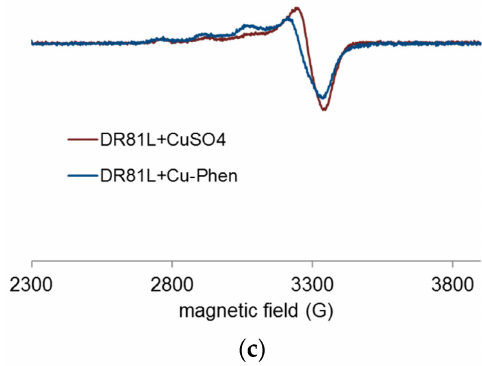
Figure 22. Experimental X-band EPR spectra recorded at 100 K in frozen aqueous solutions of ( a ) CuSO 4 and CuSO 4 + DR81 ( b ) Cu-Phen and Cu-Phen + DR81 ( c ) CuSO 4 + DR81 and Cu-Phen + DR81, at